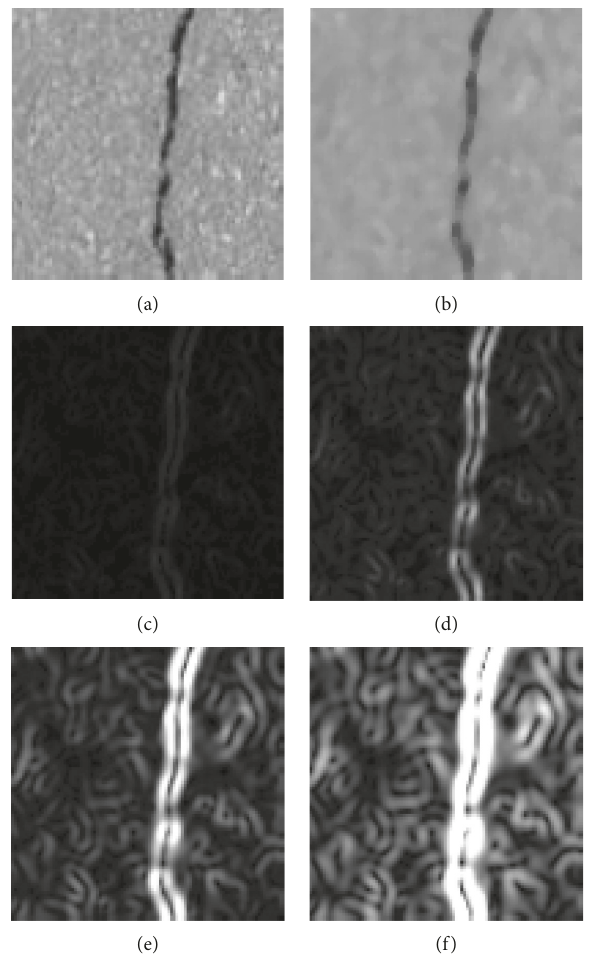
Figure 2: Examples of image enhancement with STF. (a) Pavement image. (b) Median filter enhancement. (c) GTF with r � 0.5. (d) GTF with r � 1.0. (e) GTF with r � 1.5. (f) GTF with r �